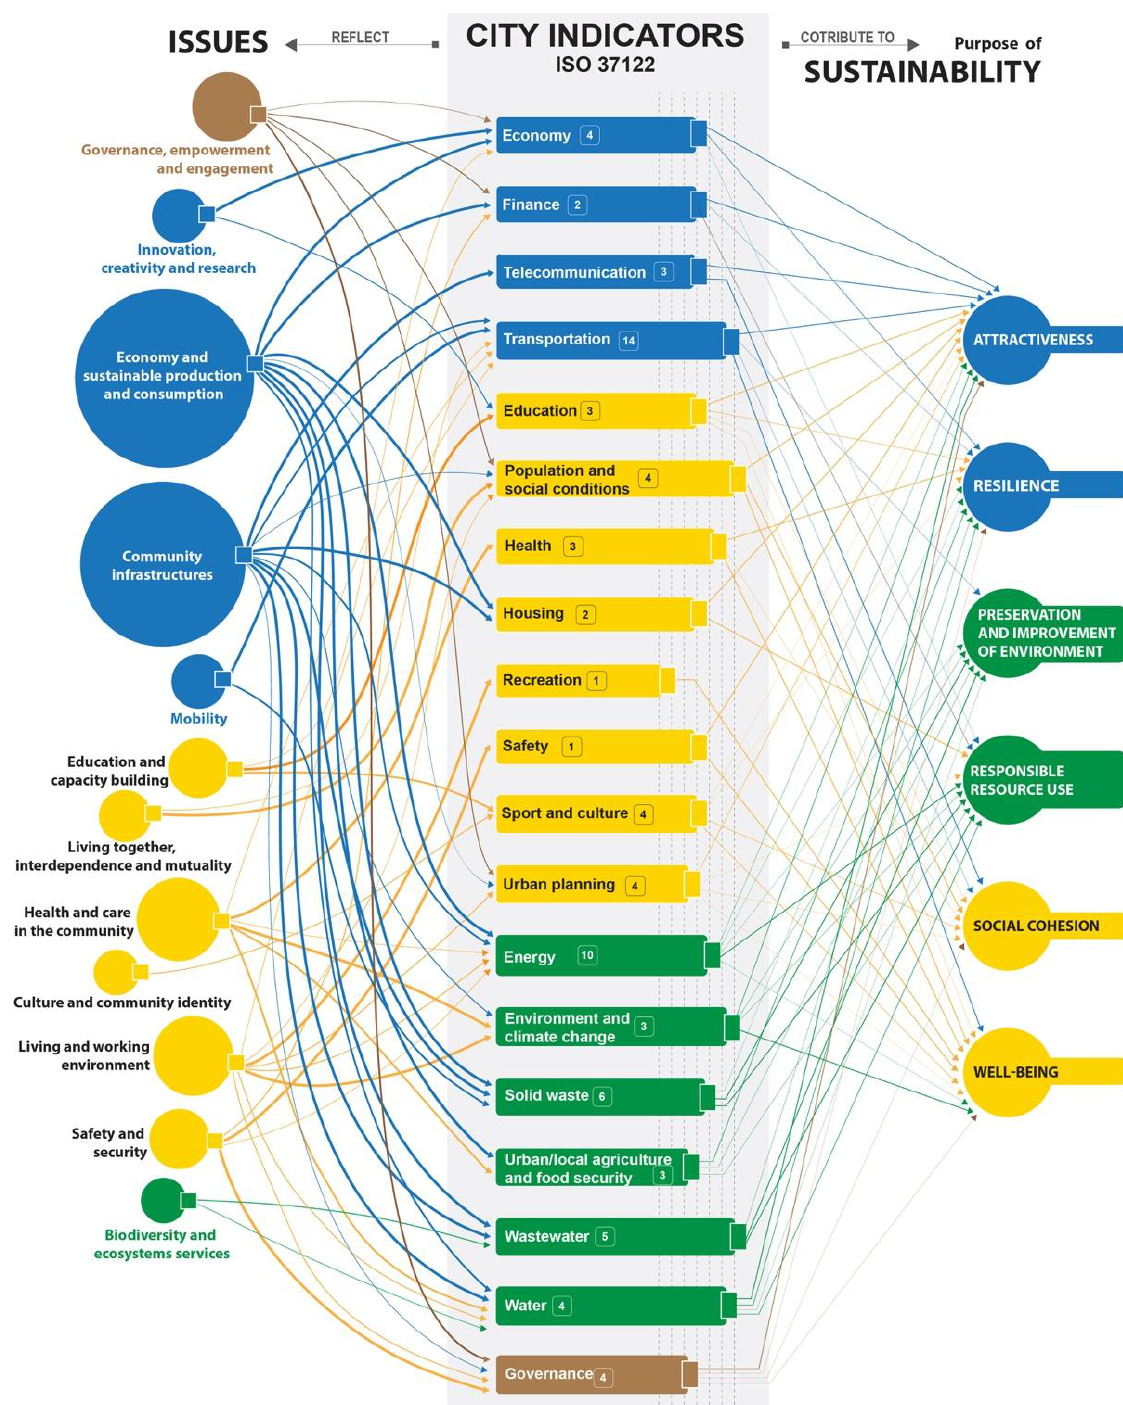
Figure 10. Themes, influences, and contribution to sustainability within ISO 37122. Source: [118]. Influence chart created by the author.